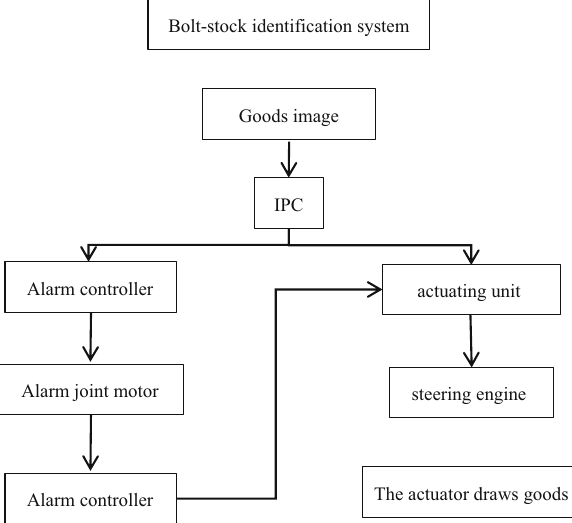
Figure 3: Control system diagram of sorting